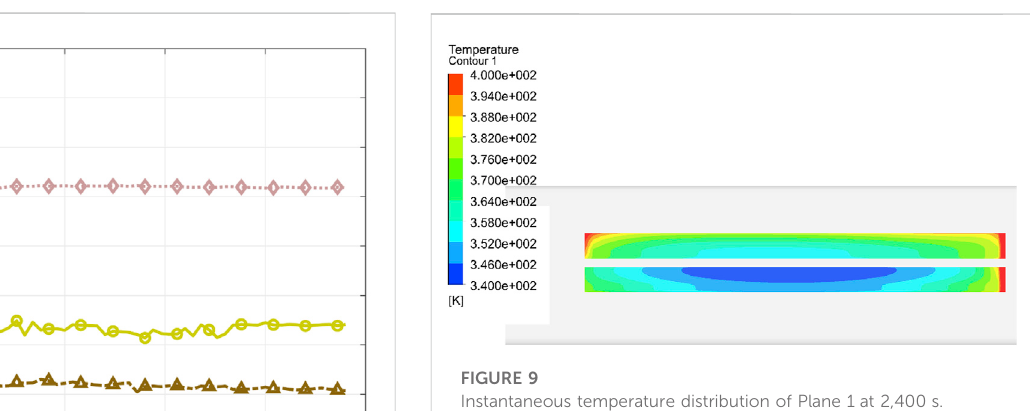
FIGURE 9 Instantaneous temperature distribution of Plane 1 at 2,400 s.